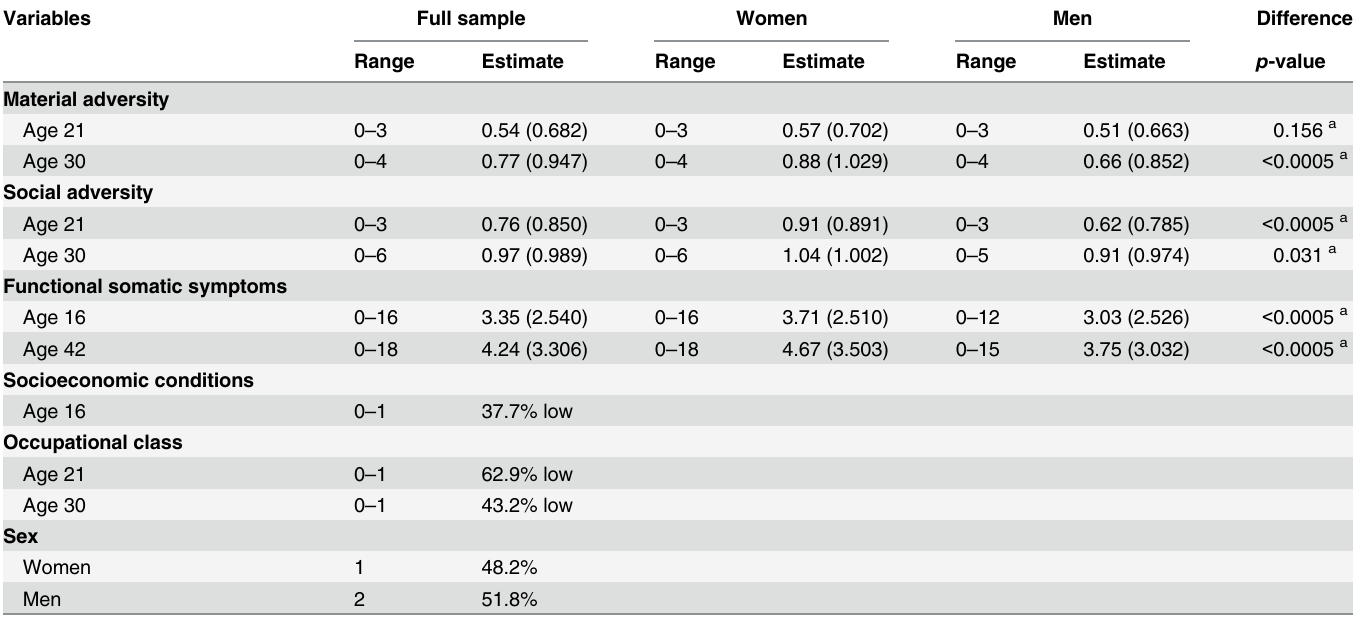
Table 1. Descriptive statistics; mean and standard deviation, in the full sample (n = 987) and stratified by sex. All the variables and control variables in the model at four points in time — respondents aged 16, 21, 30 and 42. Predictor estimates are mean (SD).